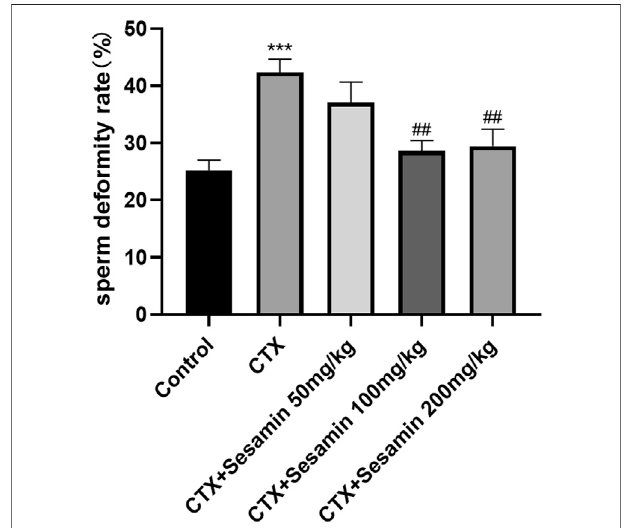
FIGURE 3 | Sesamin attenuates the sperm deformity rate induced by CTX exposure in ICR mice. The results are presented as mean ± SEM (n (cid:2) 6). *** p < 0.001 as compared with the control group; ## p < 0.01 as compared with the CTX group.